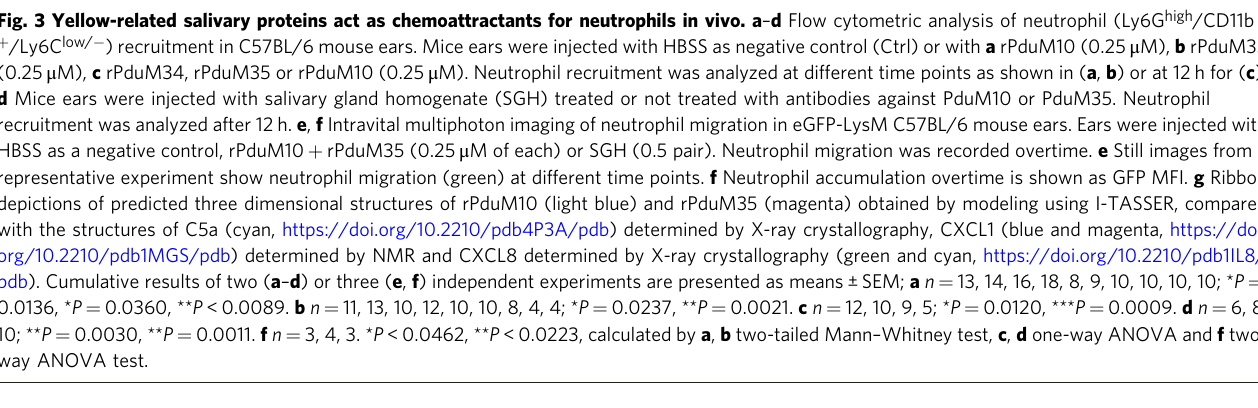
Fig. 3 Yellow-related salivary proteins act as chemoattractants for neutrophils in vivo. a – d Flow cytometric analysis of neutrophil (Ly6G high /CD11b + /Ly6C low/ − ) recruitment in C57BL/6 mouse ears. Mice ears were injected with HBSS as negative control (Ctrl) or with a rPduM10 (0.25 μ M), b rPduM35 (0.25 μ M), c rPduM34, rPduM35 or rPduM10 (0.25 μ M). Neutrophil recruitment was analyzed at different time points as shown in ( a , b ) or at 12 h for ( c